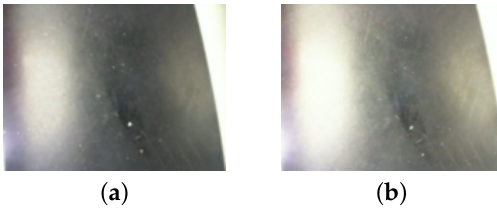
Figure 15. An example of image variation with default settings. ( a ) image of a scene before auto-exposure correction; ( b ) the same scene after auto-exposure correction.